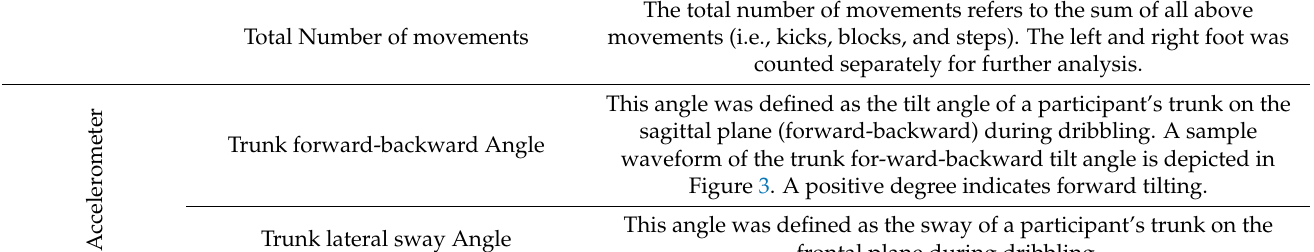
Figure 3. A positive degree indicates forward